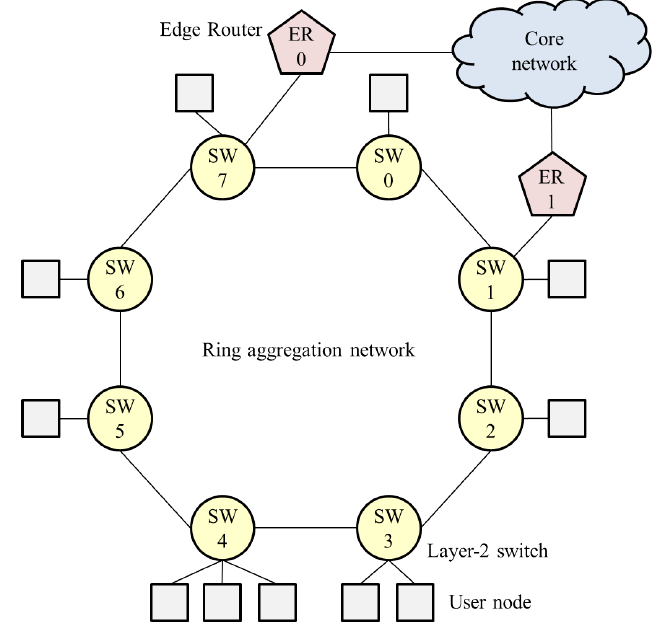
Figure 1. Ring aggregation network; Layer-2 switches (SW) compose a ring, and multiple edge routers are connected to forward traffic from user nodes to core